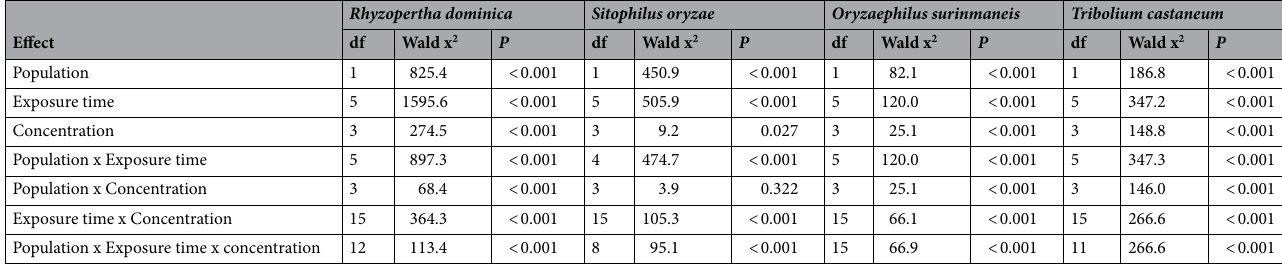
Table 3. Generalized linear model showing the effects of different exposure times and concentrations (500, 1000, 2000 and 3000 ppm) for immediate effects, for each species and population.